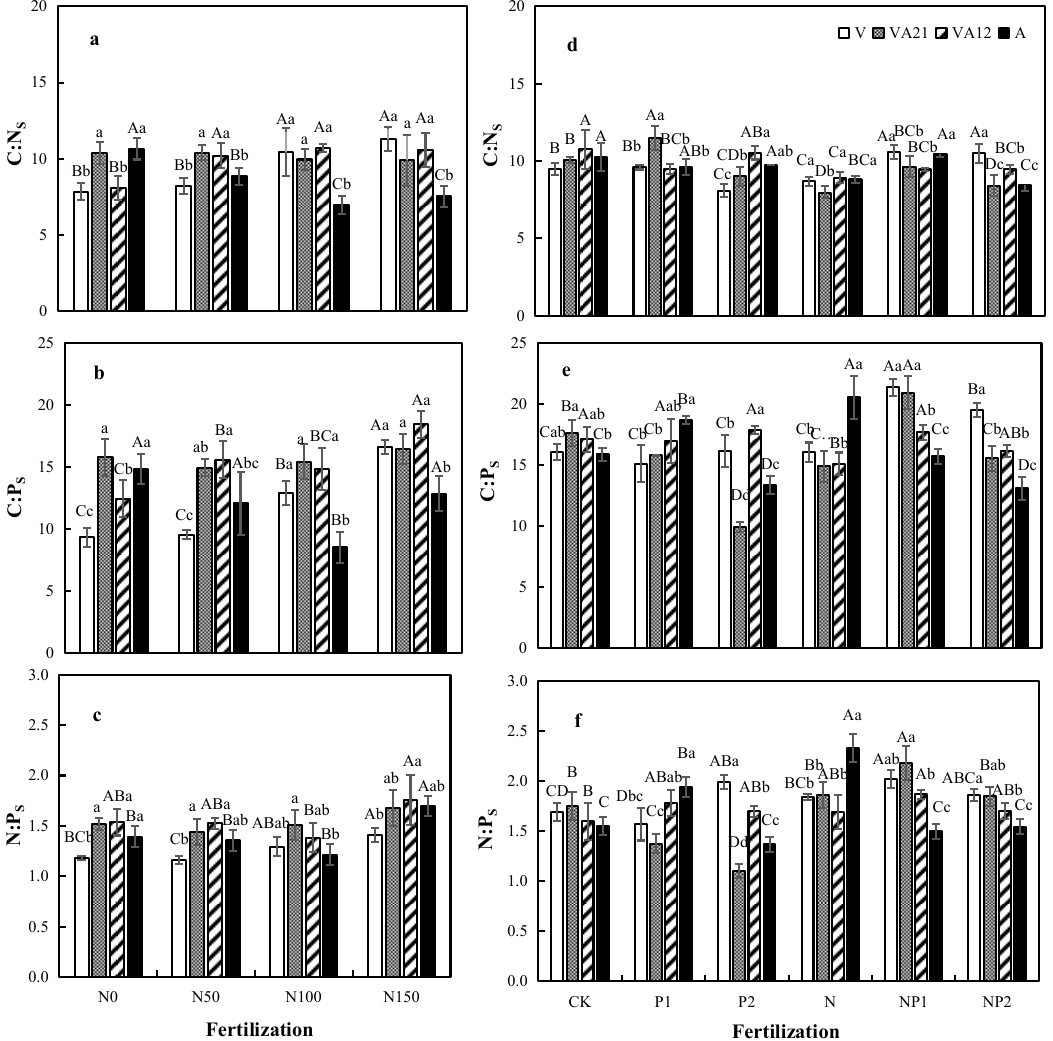
Figure 3. Soil C, N, and P stoichiometric ratios under different fertilization rates and mixing ratios in 2019 and 2020. ( a – c ) show 2019 data and ( d – f ) show 2020 data. Values are presented as mean ± S.D. ( n = 3). Different capital letters show significant difference among fertilization rates under the same mixing ratio ( p < 0.05). Different lowercase letters show significant difference among mixing ratios under the same fertilization rate ( p < 0.05).